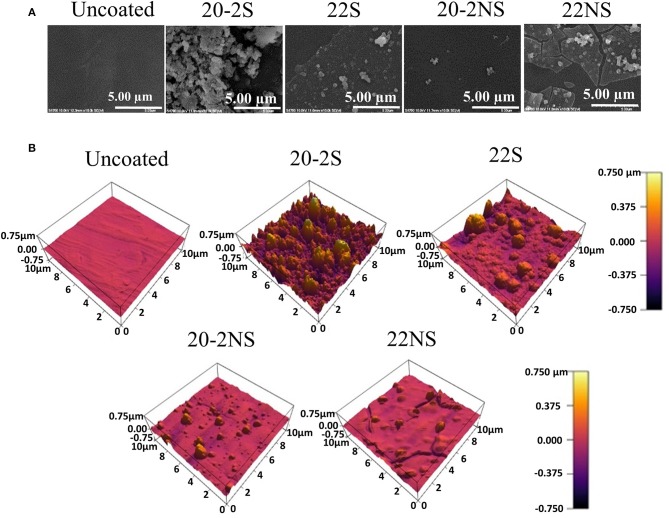
FE-SEM (A) and AFM images (B) of uncoated mesh and PDA-coated meshes.